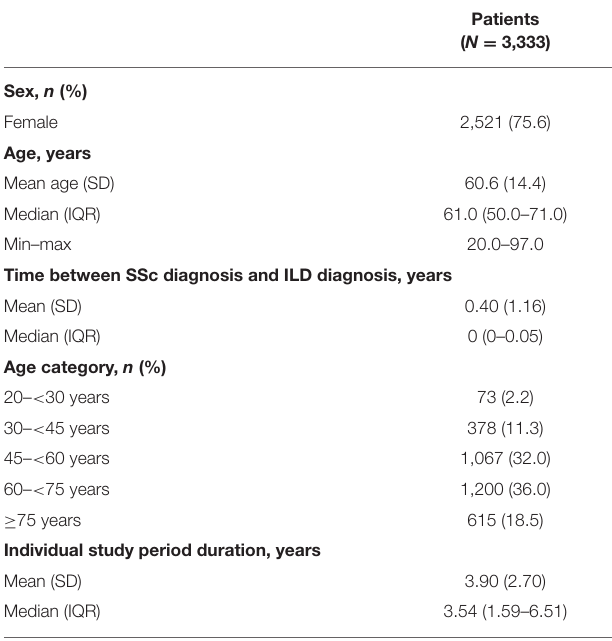
TABLE 1 | Characteristics of patients with SSc-ILD.